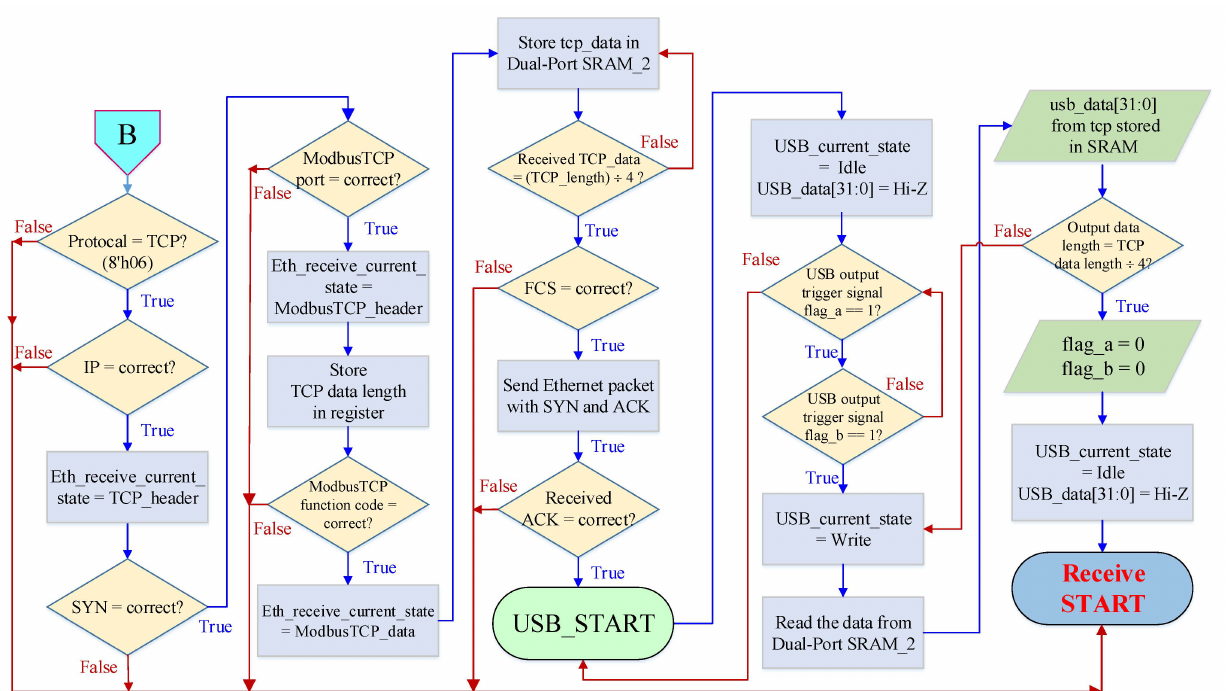
Figure 8. Flowchart of the Modbus TCP packet receiving process in the Ethernet module.